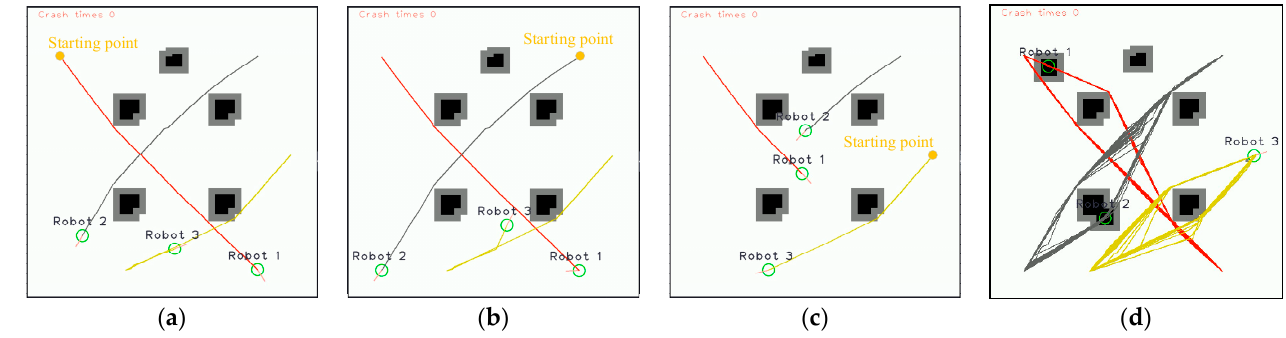
Figure 9. ( a ) The first trajectory (red line) of robot-1 arrives at the target point; ( b ) the first trajectory (gray line) of robot-2 arrives at the target point; ( c ) the first trajectory (yellow line) of robot-3 arrives at the target point; ( d ) the trajectories of all robots running between the starting point and the target point more than 50 times, respectively.